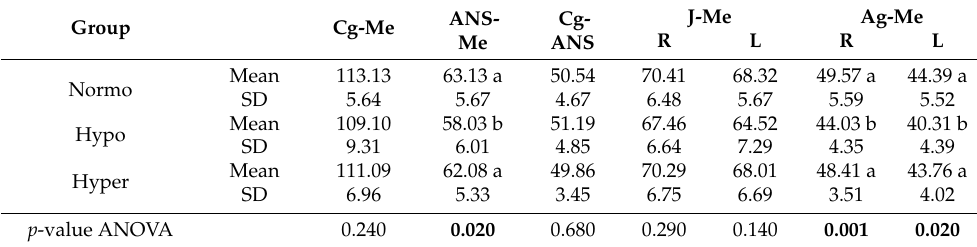
Table 5. Asymmetry vertical variables, reported as means (mm) and Standard Deviations (SD) in the three study groups (Normo: Normodivergent; Hypo: Hypodivergent; Hyper: Hyperdivergent). Statistically significant p -values are reported in bold. Different letters indicate statistically significant difference between groups in the Tukey Post Hoc